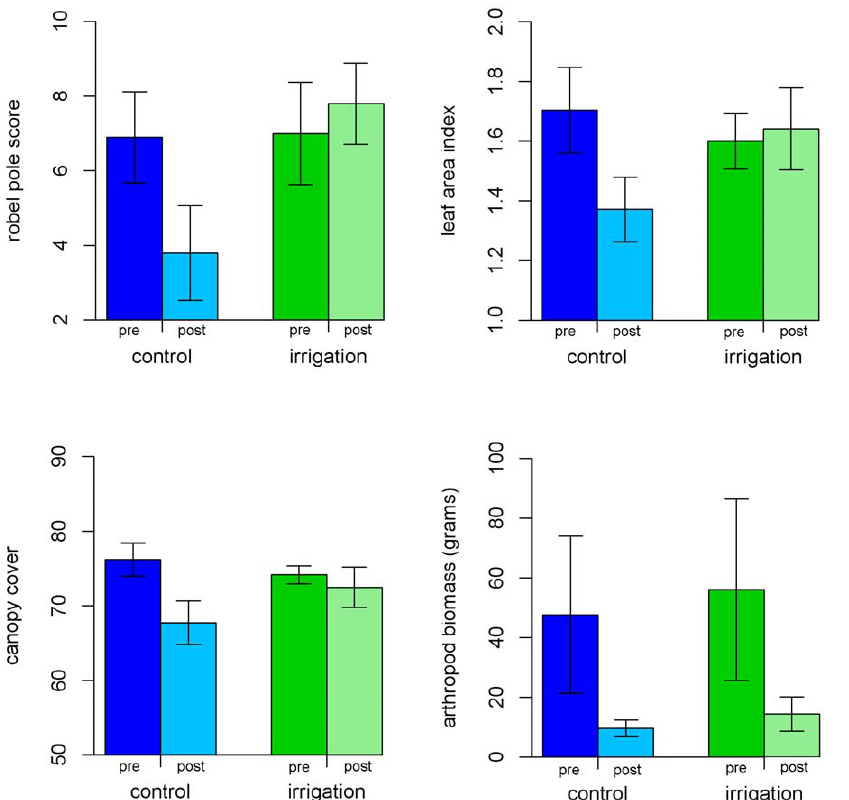
Figure 5. Variation in canopy cover, leaf area index, Robel measures of vegetation greenness and arthropod biomass on control and irrigated plots at Font Hill, Jamaica (values include mean and 95% confidence interval). Columns labelled ‘‘pre’’ are the early season measurements prior to irrigation (late January/early February), while columns labelled ‘‘post’’ are the late season conditions after irrigation (late March/early April).